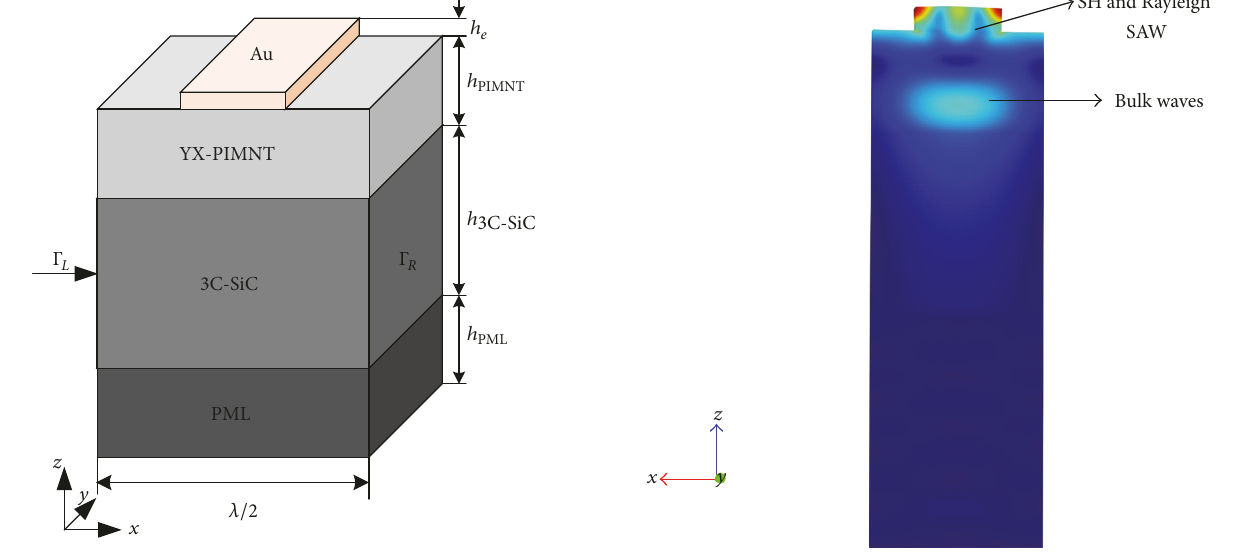
Figure 2: Image of the calculated acoustic wave radiation.